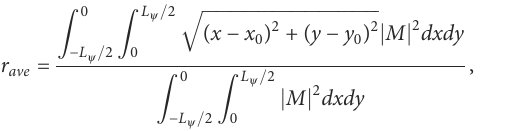
ffiffiffi p hk 2 = z : 2,1,5, respectively. 2 0 = 0 0